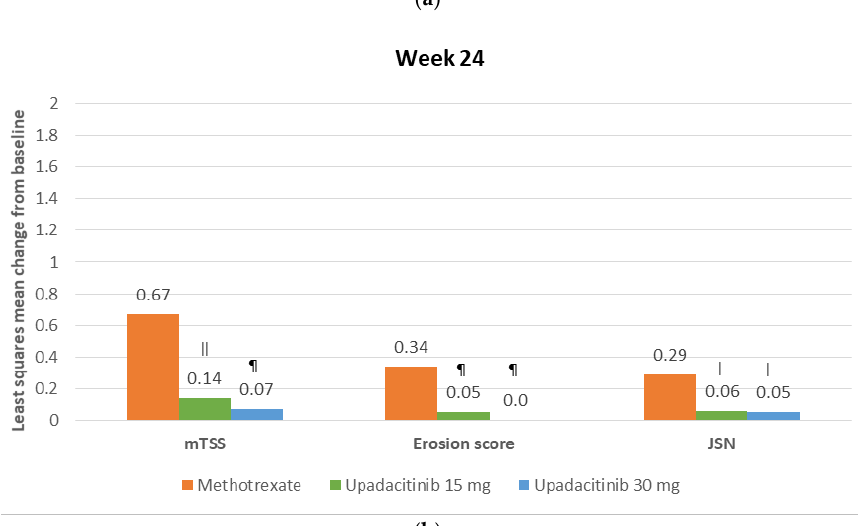
Figure 3. ( a ). Radiographic progression in the SELECT-COMPARE trial at week 26 and 48. † 0.001 for upadacitinib versus placebo + methotrexate for the comparisons at each timepoint. Adapted and reproduced from Fleischmann RM, Genovese MC, Enejosa JV, Mysler E, Bes-sette L, Peterfy C, Durez P, Ostor A, Li Y, Song IH. Safety and effectiveness of upadacitinib or adalimumab plus methotrex-ate in patients with rheumatoid arthritis over 48 weeks with switch to alternate therapy in patients with insuffi-cient response. Ann Rheum Dis. 2019 Nov;78(11):1454-1462, © 2019, with permission from BMJ Publishing Group Ltd. ( b ). Radiographic progression in the SELECT-EARLY trial. (cid:112) 0.05 upadacitinib versus methotrexate. (cid:107) 0.01 upadacitinib versus methotrexate. ¶ 0.001 upadacitinib versus methotrexate. Reproduced with permission from van Vollenhoven R, Takeuchi T, Pangan AL, Friedman A, Mohamed MF, Chen S, Rischmueller M, Blanco R, Xavier RM, Strand V. Efficacy and Safety of Upadacitinib Monotherapy in Methotrex-ate-Naive Patients With Moderately-to-Severely Active Rheumatoid Arthritis (SELECT-EARLY): A Multicenter, Multi-Country, Randomized, Double-Blind, Active Comparator-Controlled Trial. Arthritis Rheumatol. 2020 Oct;72(10):1607-1620, © 2020 The Au- thors. Arthritis & Rheumatology published by Wiley Periodicals LLC on behalf of American College of Rheumatology. JSN—joint space narrowing; mTTS—modified total Sharp/van der Heijde